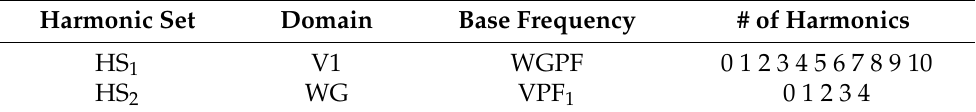
Table 1. Considered harmonic sets with base frequencies and associated number of